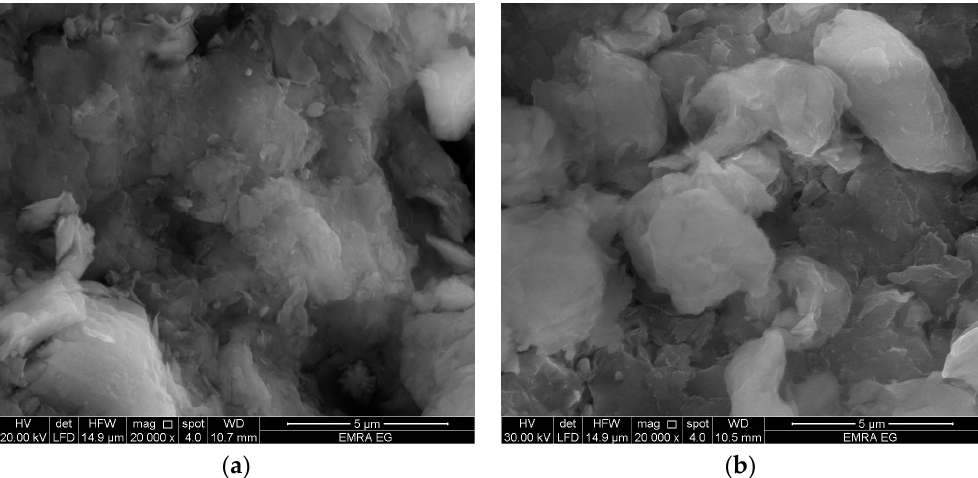
Figure 2. Scanning electron microscopy (SEM) images of ( a ) Na-bentonite and ( b ) HQ-bentonite.